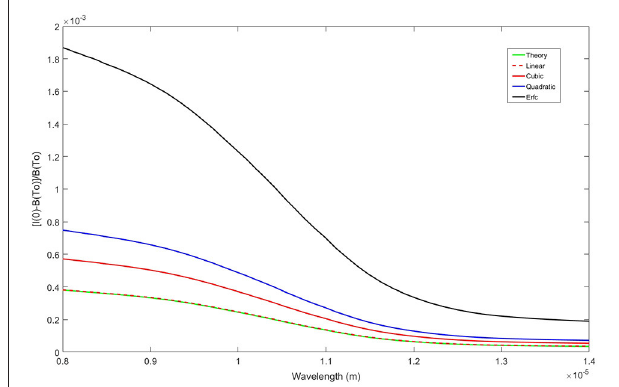
FIGURE 10 | Comparison of LWIR radiation emitted from an air-water surface made dimensionless with the Planck spectrum for several thermal stratifications for a constant surface temperature condition. As with the mid-wave case, the numerical results for the linear profile show very good agreement with the theoretical